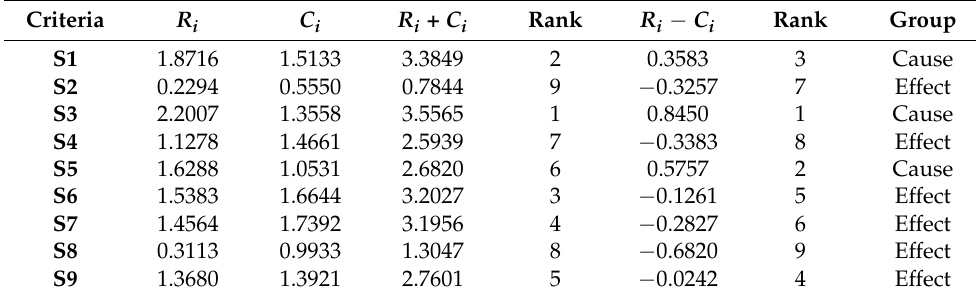
Table 5. Degree of total influence of each